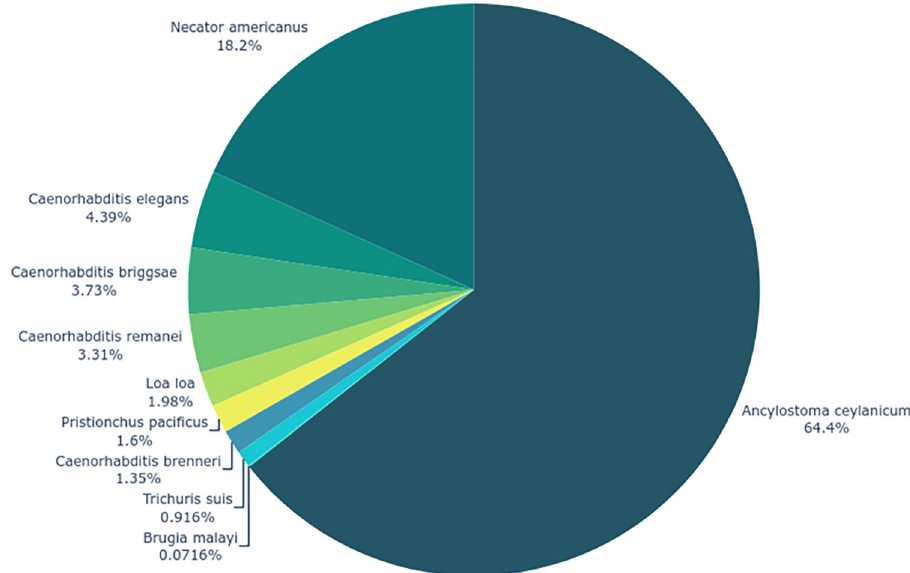
Fig 3. Top ten BLASTX hits of H . indica with other